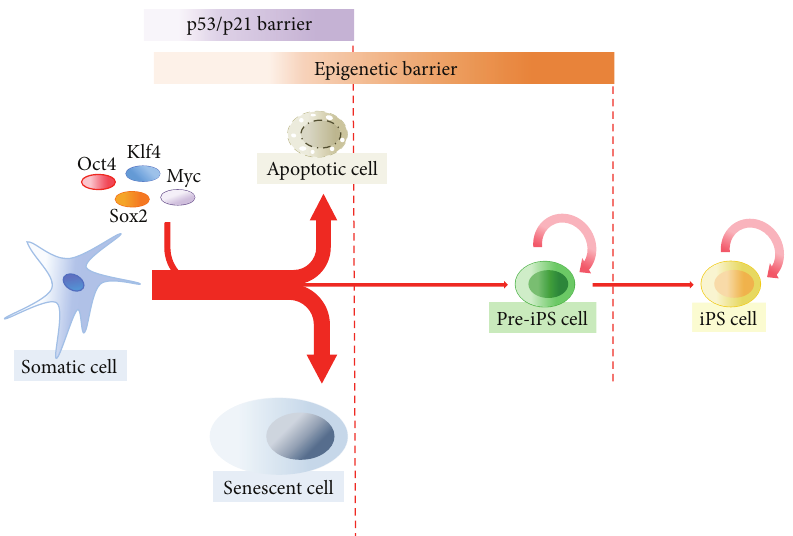
Figure 5: Scheme depicting cellular reprogramming and barriers affecting efficiency of the